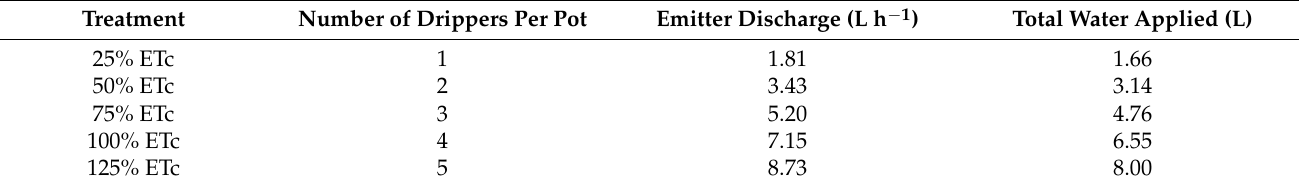
Table 1. Treatments tested, number of drippers per pot, average emitter discharge, and total water applied per pot on all irrigation events during the experiment.